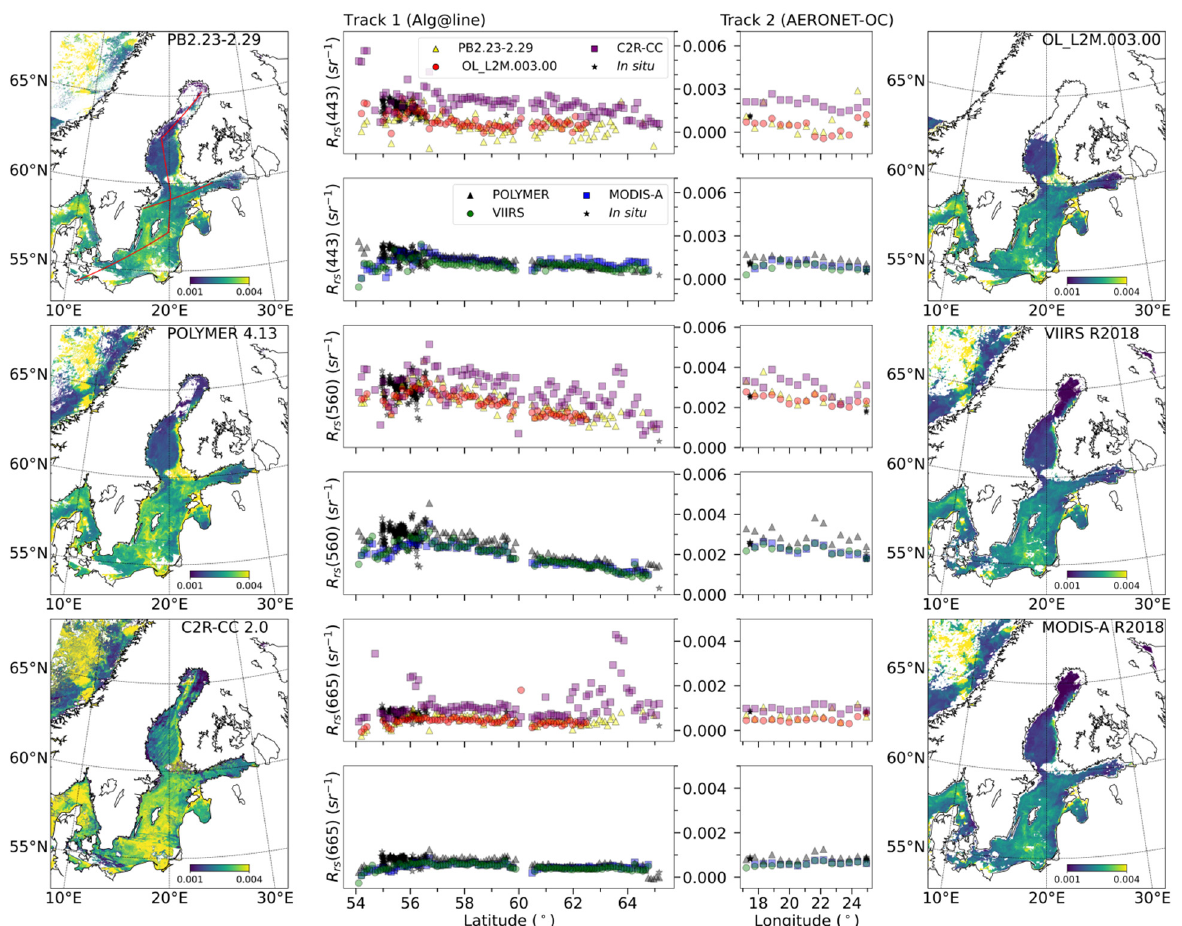
Figure 7. Composite R rs ( λ ) images for each AC for the Baltic Sea for the period from 11 to 17 June 2016 are shown on the left and right panels. On the left panel, from top to bottom the images are for; OLCI-A pb 2, POLYMER v4.13 and C2R-CC v2.0. On the right panel, from top to bottom, the images are for OLCI-A OL_L2M.003.00, VIIRS R2018 and MODIS-Aqua R2018. Centre panels are comparisons of R rs ( λ ) at 443, 560 and 665 nm for each AC along two transects shown as red lines in the top left image. The data were extracted at every 20 km for each AC model. The centre-left data are R rs ( λ ) for the different ACs extracted from the north-south transect from the Gulf of Bothmia to the Baltic Proper (shown in the top left pb 2.23–2.29 image). The centre-right data are R rs ( λ ) for the different ACs for the east-west transect from the head of the Gulf of Finland through the HLT to the GDL. For these transects, The black points are in situ R rs ( λ ), yellow triangles are OLCI-A pb 2.23–2.29, red circles are OL_L2M.003.00, purple squares are OLC-A C2R-CC, grey triangles are OLCI-A POLYMER v4.13, green circles are VIIRS and blue squares are